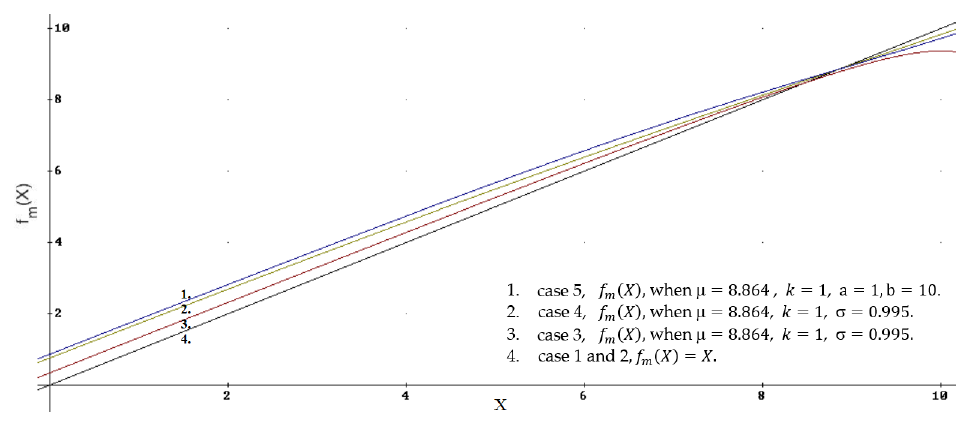
Figure 6. f m ( X ) functions for different cases; µ = 8.864, σ = 0.995, k = 1. It is convenient to start considering the graphs from the bottom, from the line num- bered 4 (black). These are cases 1 and 2, where the function f ( θ ) is given by a uniform distribution, which means the absence of accumulated, a priori , information. This function is f m ( X ) = X ; i.e., the estimate is not adjusted. It is convenient to compare the other cases with the line numbered 4 by fixing the influence of a priori information on changes in the function f m ( X ) . Deviations from this line illustrate the influence of the a priori information on decision-making.